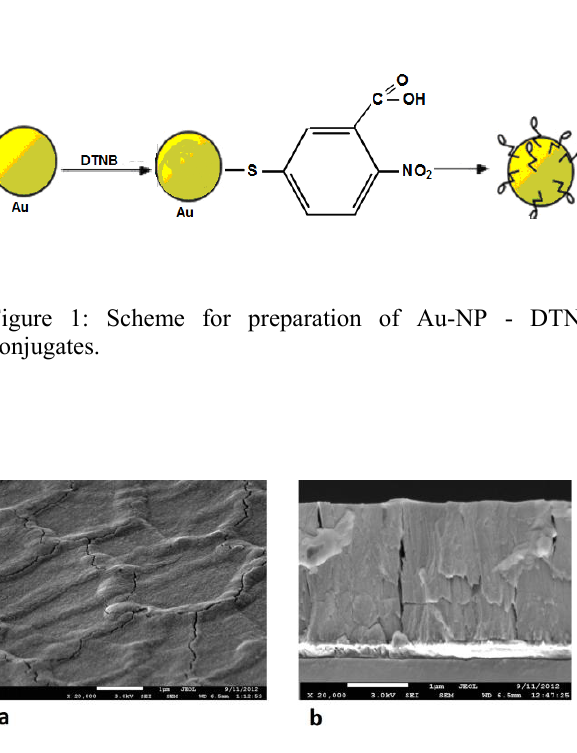
Figure 2: (a) General SEM view of the CeO2 structure; (b)cross section of CeO2 film.